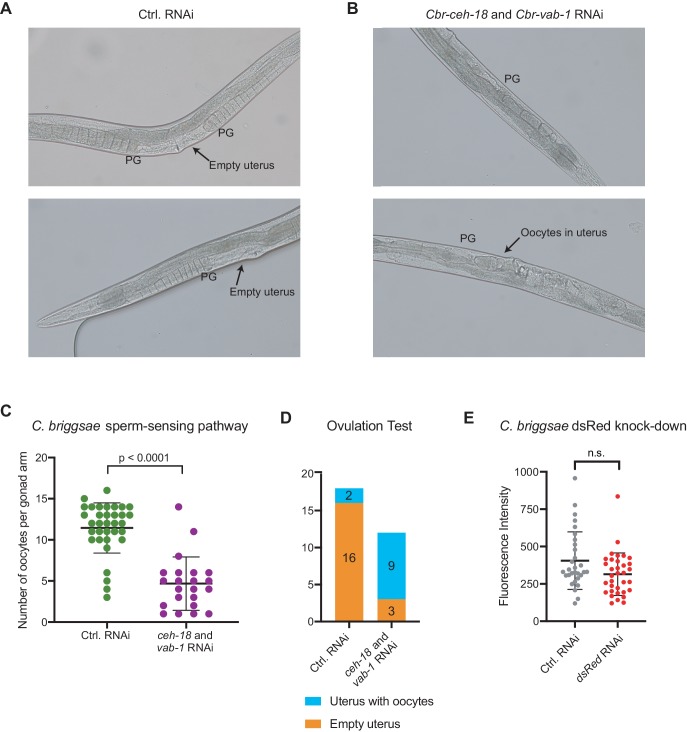
RNAi knock-down of the sperm-sensing pathway in C.briggsae.(A-B) Representative images of the germlines of feminized (mfIs42[Cel-sid-2; Cel-myo-2::DsRed]; she-1[v35]) C. briggsae individuals cultured on control RNAi (empty vector, A) or Cbr-ceh-18 and Cbr-vab-1 RNAi (B). The proximal gonads (PG) are indicated. (C) Quantification of the number of oocytes present in the gonads of feminized (mfIs42[Cel-sid-2; Cel-myo-2::DsRed]; she-1[v35]) C. briggsae individuals cultured on control RNAi (empty vector, green data points) or Cbr-ceh-18 and Cbr-vab-1 RNAi (purple data points). Each data point represents one gonad arm. 12–18 animals were counted, and the p-value was calculated using the Mann-Whitney test. (D) The presence of unfertilized oocytes in the uterus of feminized (mfIs42[Cel-sid-2; Cel-myo-2::DsRed]; she-1[v35]) C. briggsae individuals cultured on control RNAi (empty vector) or Cbr-ceh-18 and Cbr-vab-1 RNAi. 12–18 animals were quantified. (E) Knock-down in the C. briggsae pharynx bulb of the transgenic marker Cele-myo-2::DsRed by ingested dsRNA was measured on day 8 of life. 30–34 animals were measured and the p-value was calculated using the Mann-Whitney test.